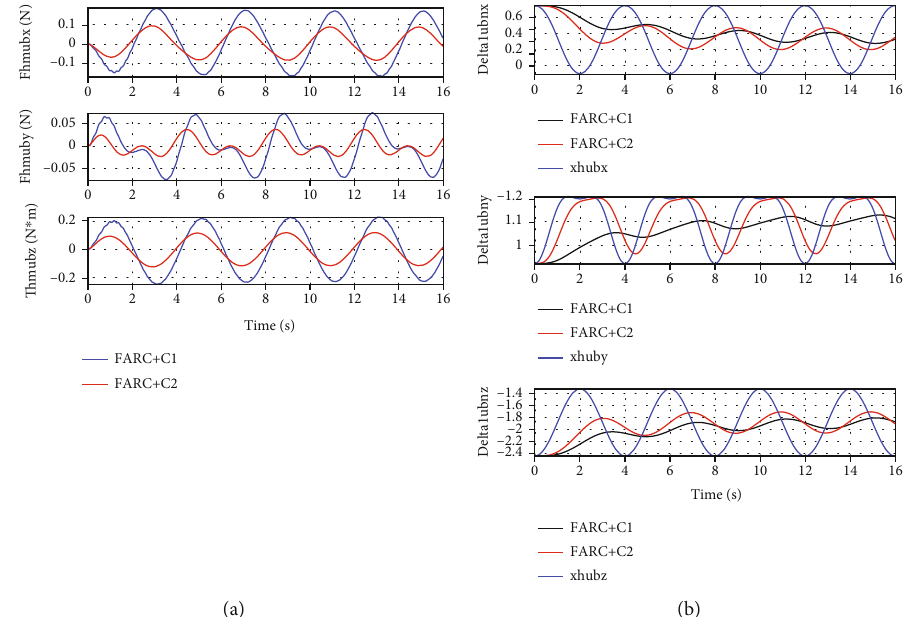
Figure 8: Simulation results of double leg support for Set2: (a) human-machine interaction force at the back, (b) parameter estimation of Δ at the 1 n